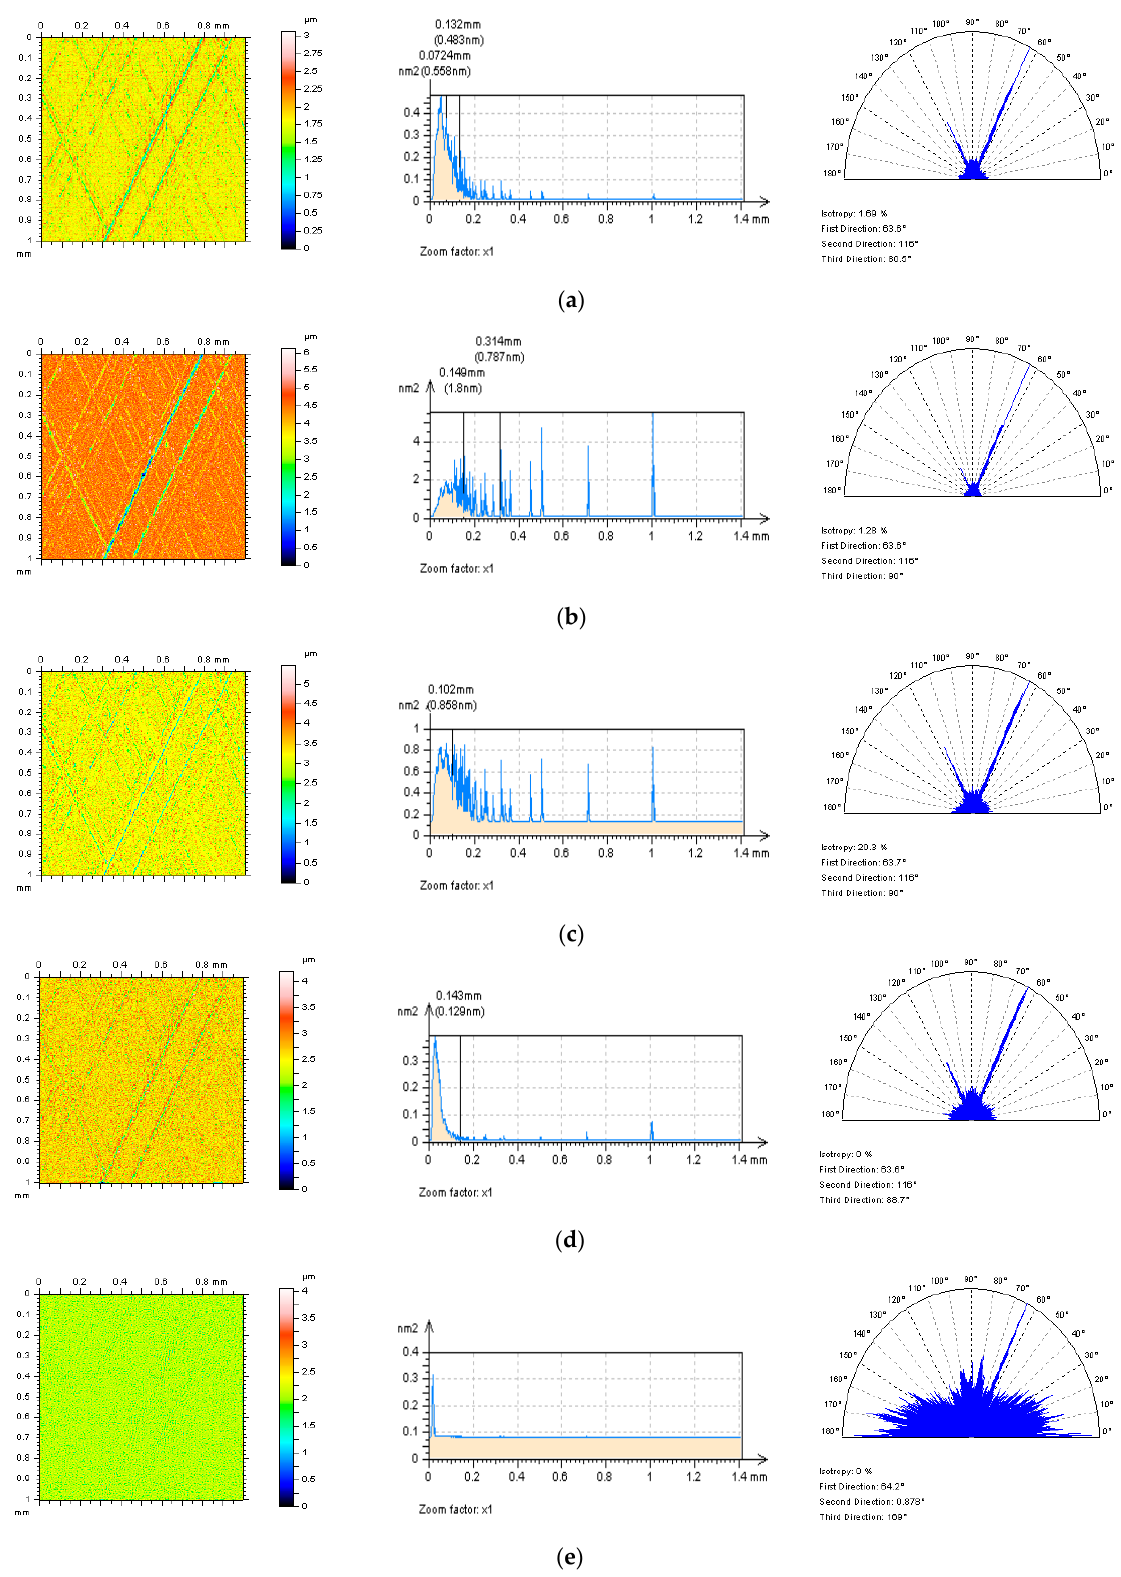
Figure 11. NSs (left column), PSDs (middle column) and texture direction graphs (right column), specified for results of 0.7 mm/s measurements of the running-in plateau-honed cylinder liner surface texture, obtained by the application of various S-filtering methods (cut-off = 0.025 mm), as follows: GF ( a ), RGF ( b ), DMF ( c ), SF ( d ) and FFTF ( e ).